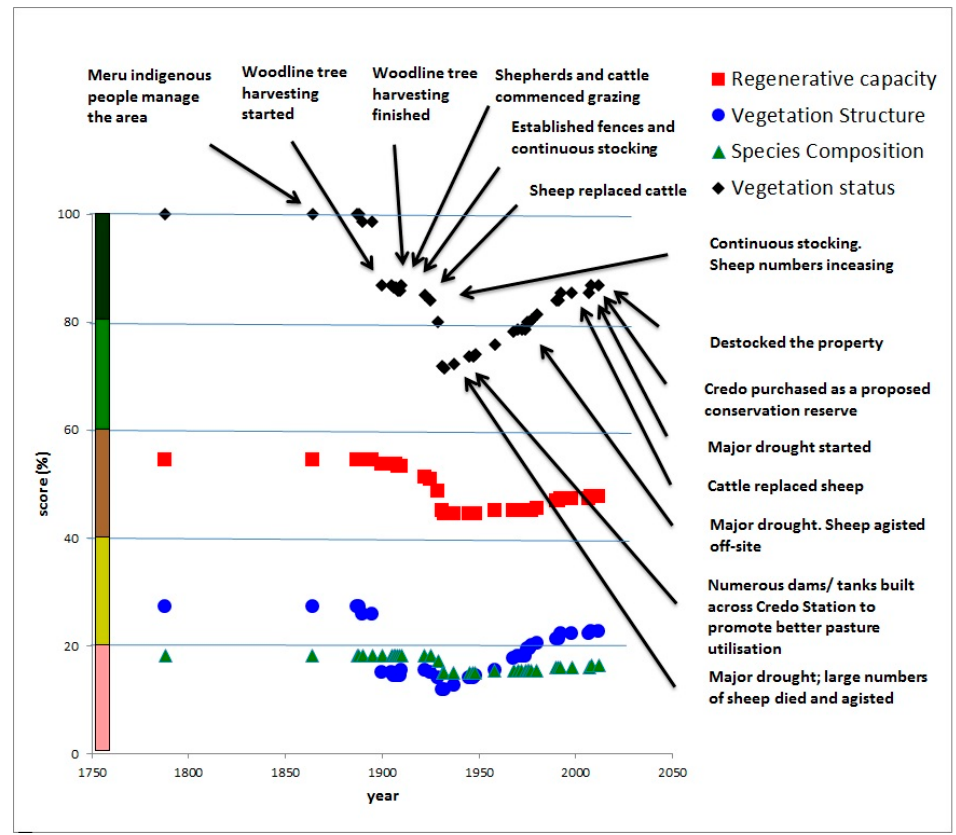
Figure 11. Case study 10: Chadwin paddock, Credo Station, dry agro-climate region, eucalypt woodland.